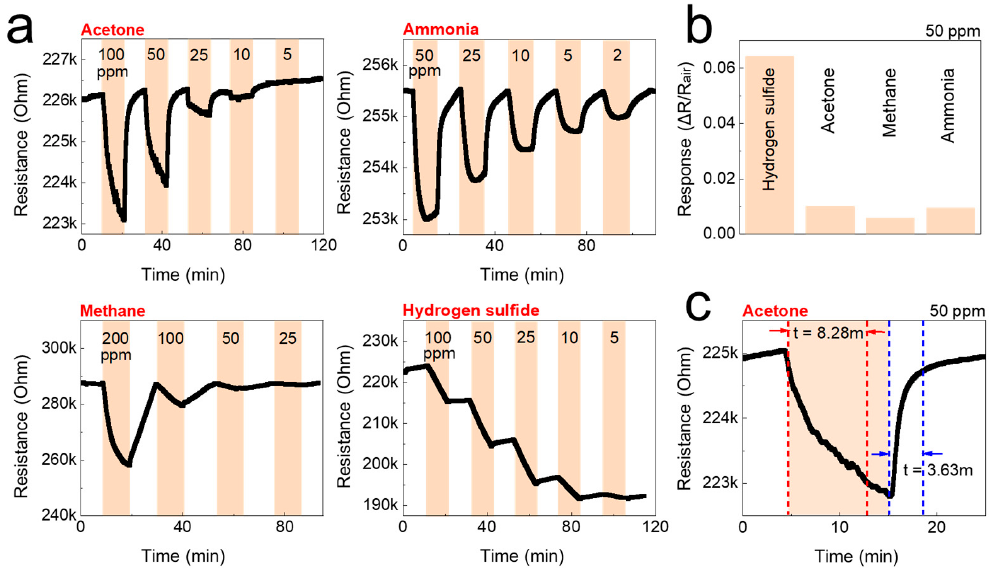
Figure 6. Gas-sensing performance of the CNF sensor against acetone, ammonia, methane, and hydrogen sulfide at room temperature. ( a ) Real-time resistance behavior of the CNF sensors as a function of the concentration of the test gases; acetone, ammonia, methane, and hydrogen sulfide. ( b ) The gas response of the CNF sensors to 50 ppm of the test gas. ( c ) Gas response time of the CNF sensors to 50 ppm of acetone.